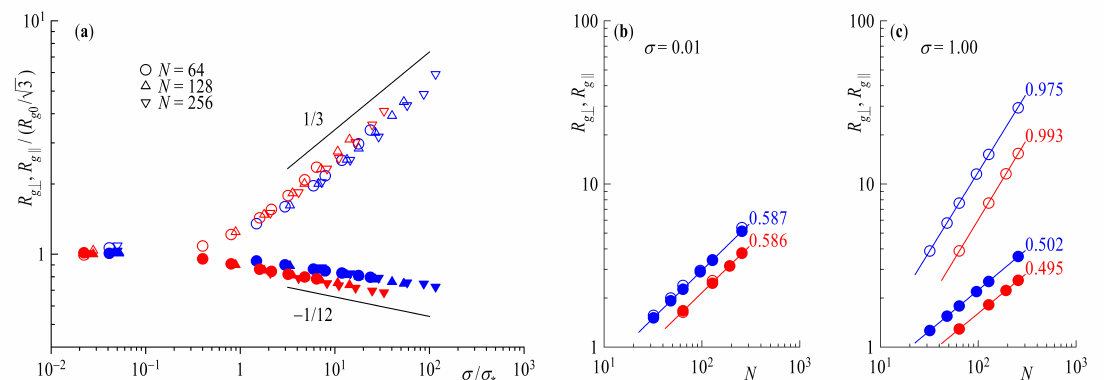
Figure 6. ( a ) Parallel component R g (cid:107) (full symbols) and normal component R g ⊥ (open symbols) of the Radius of Gyration as a function of surface overlap concentration σ ∗ and ( b ) as a function of chain length N for surface coverage σ = 0 ( c ) and σ = 1. Straight lines indicate power law fits with scaling exponents shown next to the line. Red symbols are rings and blue for